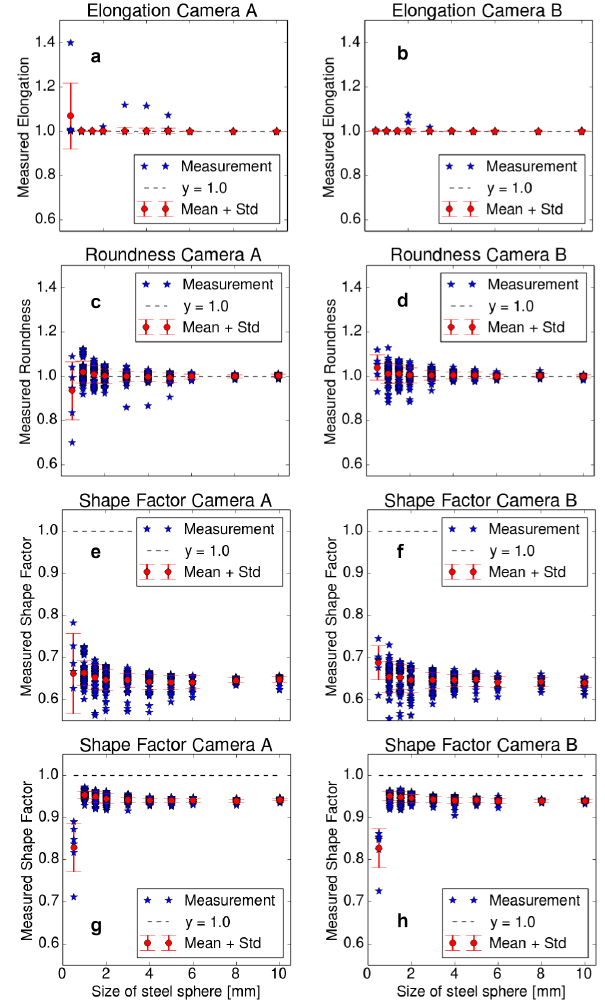
Figure 10. Comparison between measured and expected values for the shape parameters. Elongation (a, b) , roundness (c, d) , shape fac- tor with (g, h) and without (e, f) treatment with a blurring edge